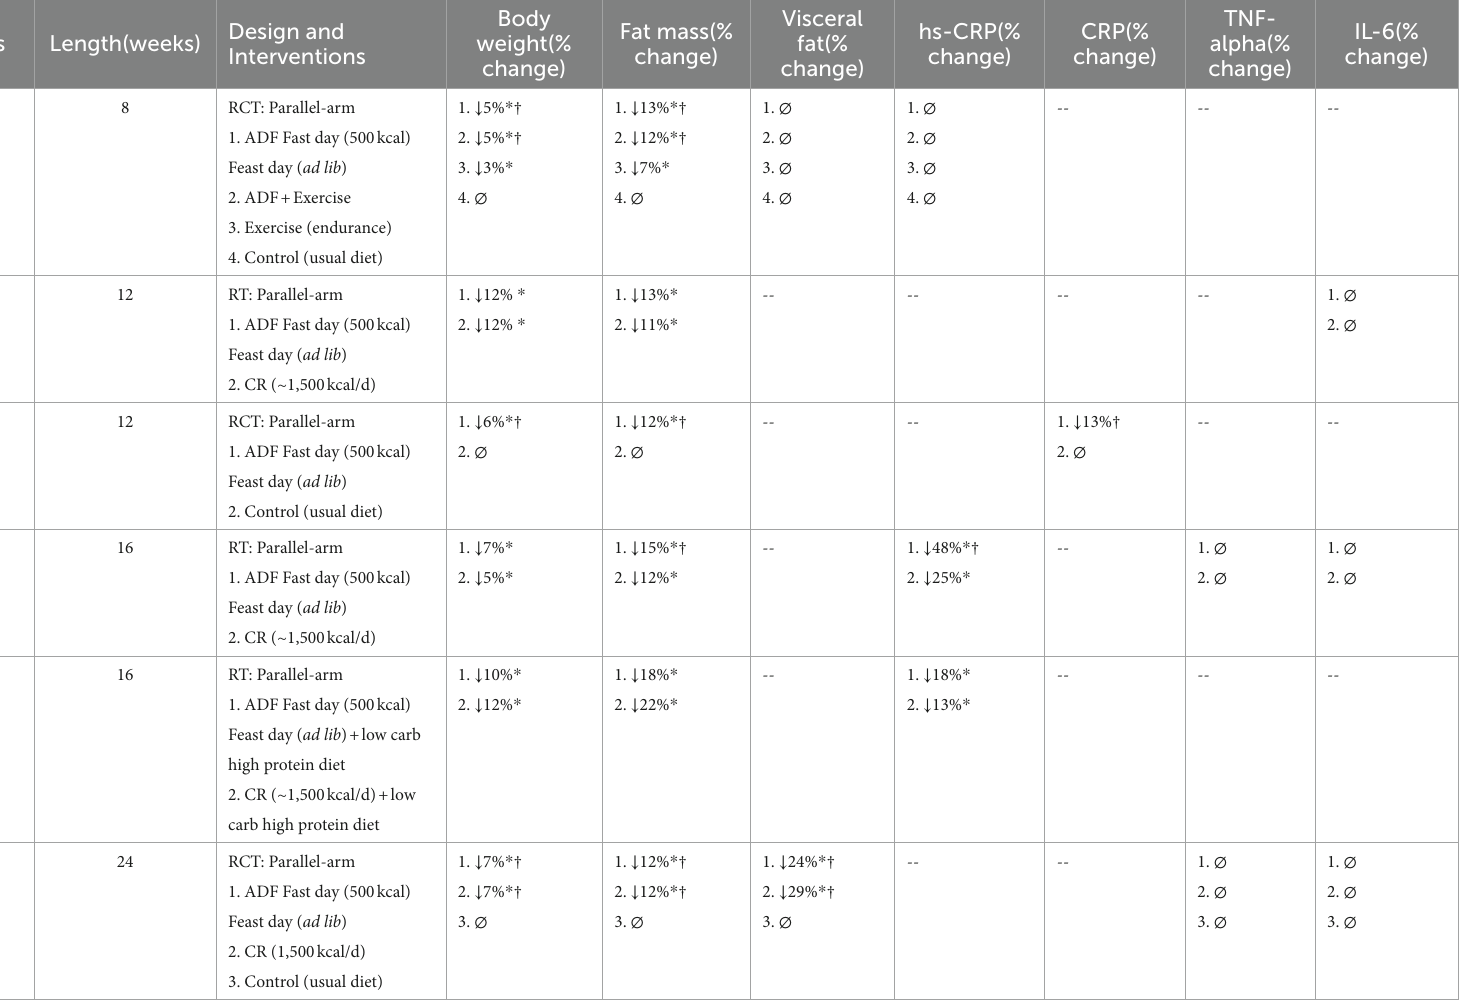
TABLE 2 Effect of alternate day fasting on circulating inflammatory markers in adults with obesity.